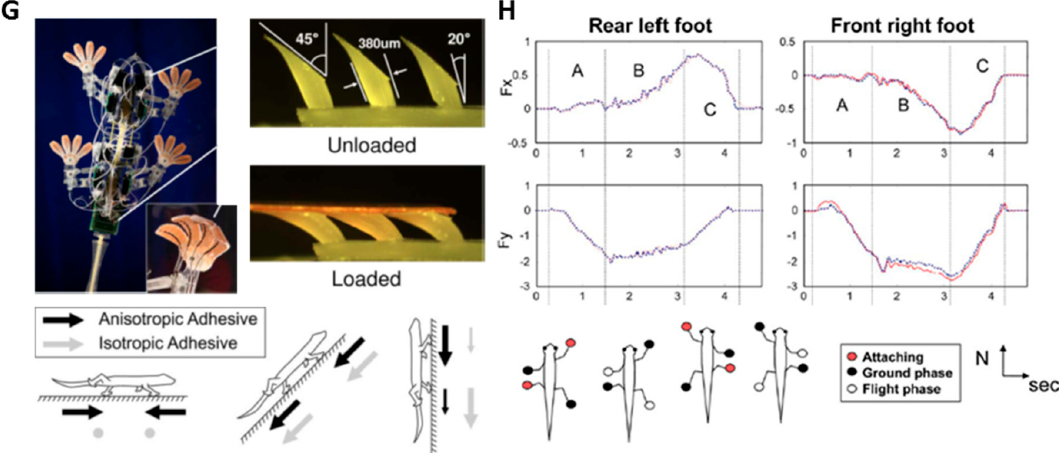
Figure 6. Transfer printing tool and robotics applications. ( A , D ) SEM images of angled microstructures for transfer printing ( A : Reproduced from [4], with permission from John Wiley & Sons; D : Reproduced from [5], with permission from the American Chemical Society); ( B , E ) Silicon inks transferred on structured adhesiveless substrates ( B : Reproduced from [4], with permission from John Wiley & Sons; E : Reproduced from [5], with permission from the American Chemical Society); ( C , F ) The mechanism for the energy release rate with two different directions of the angled posts ( C : Reproduced from [4], with permission from John Wiley & Sons; F : Reproduced from [5], with permission from the American Chemical Society); ( G ) Gecko-like robotics, a Stickybot, with directional PU hairs; ( H ) Adhesion force data of the robot’s feet ( G,H : Reproduced from [6], with permission from IEEE).